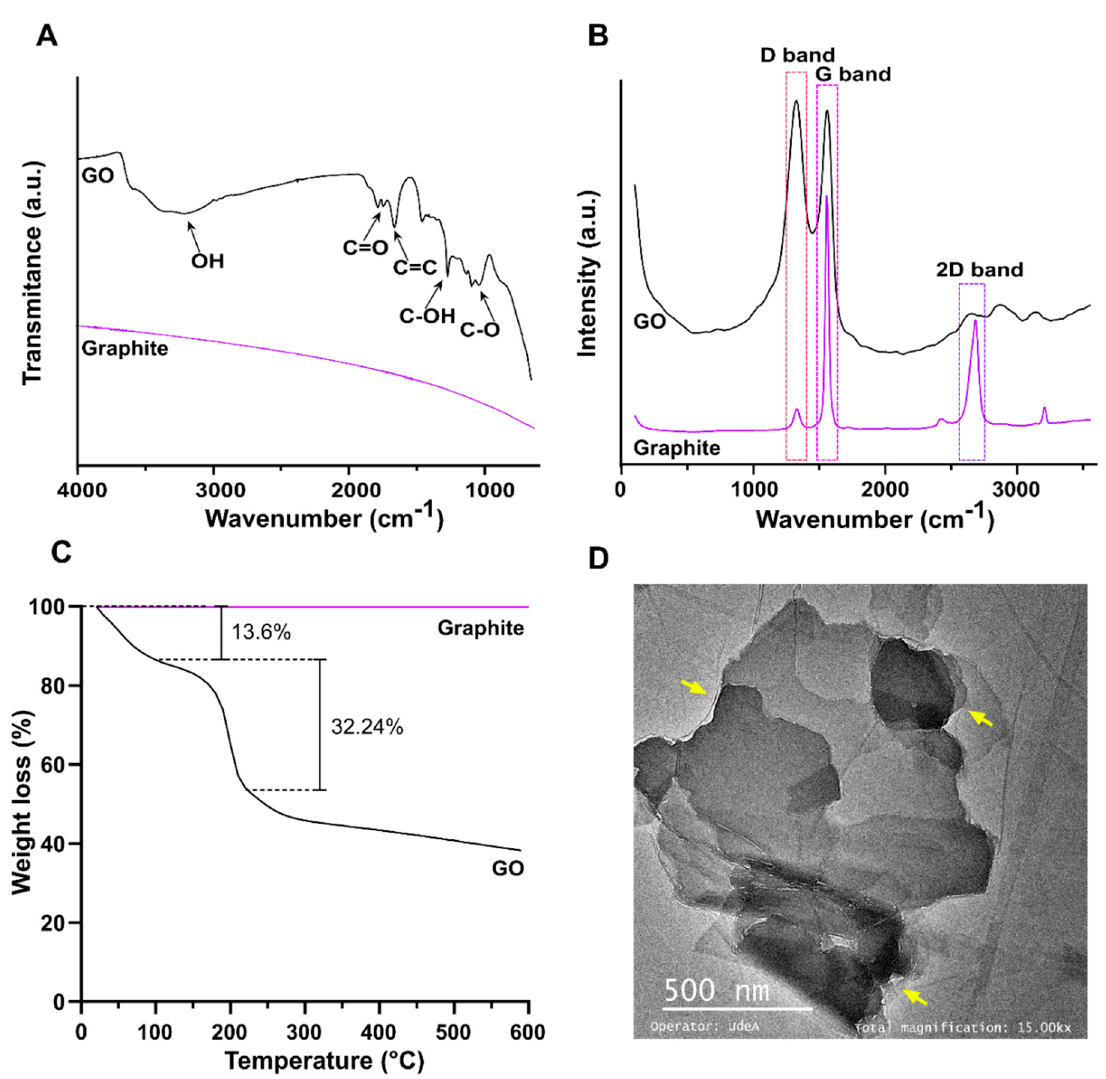
Figure 5. Physicochemical characterizations of GO. ( A ) FTIR spectra of chitosan, graphite, and GO. ( B ) Raman spectra of graphite and GO. ( C ) TGA of GO. ( D ) TEM of GO. ( B ) Raman spectra of graphite and GO. ( C ) TGA of GO. ( D ) TEM of